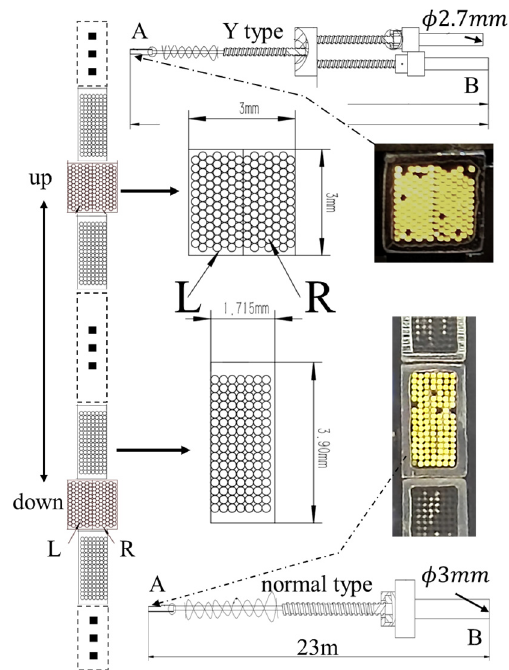
Figure 5. Arrangement design of the slots for fiber bundles, A \ B-side design of the fiber bundles, and their pictures. Side A is defined as the input face located at the image face, and side B is the output side inserted into the polychromator. “L” is left, and “R” is right.